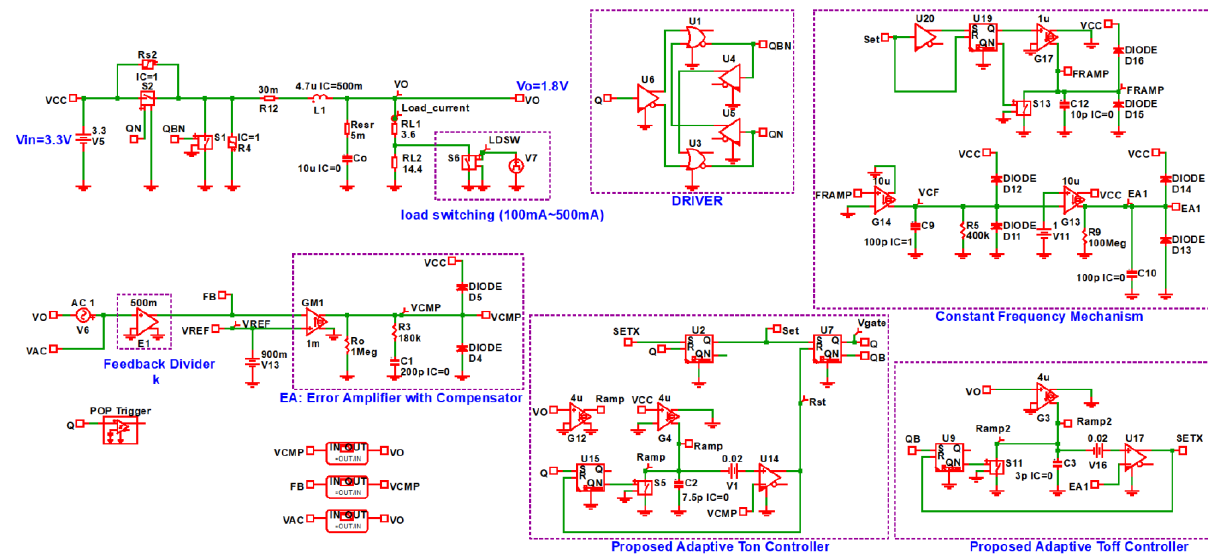
Figure 6. Schematic of the proposed converter.